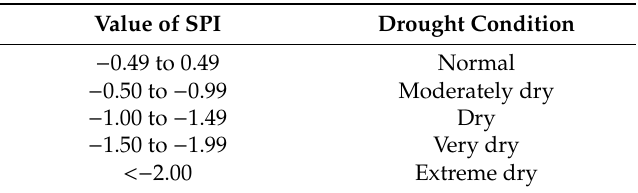
Table 3. Drought classification based on SPI values [6].